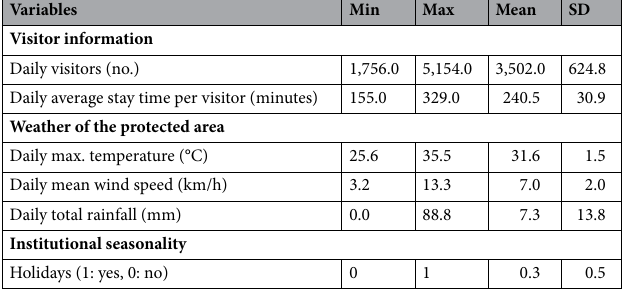
Table 1. Descriptive statistics of the study data. The variables were measured from May to December